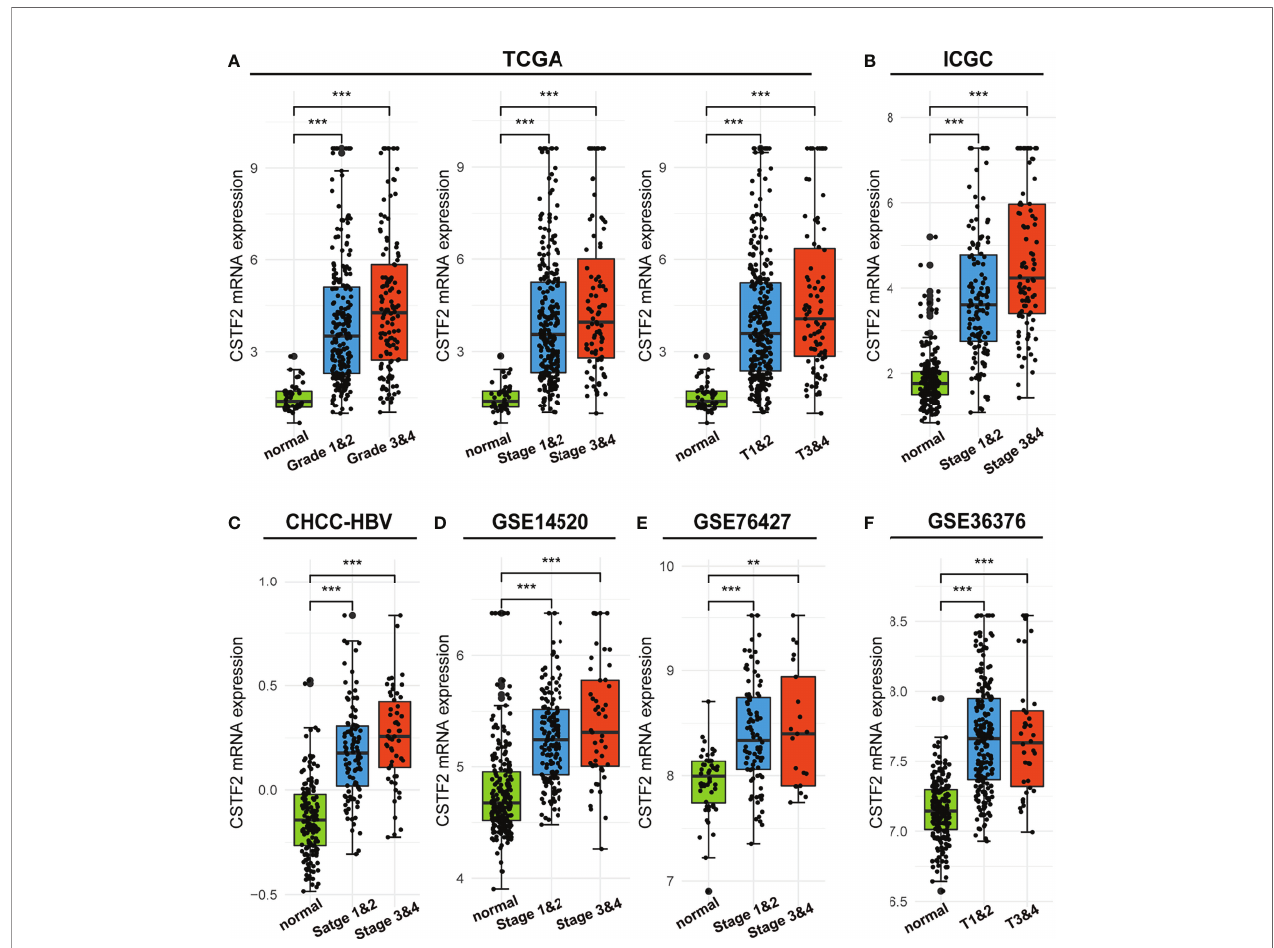
FIGURE 3 | The mRNA levels of CSTF2 were correlated with the advanced clinical stage in HCC in different databases. (A-F) The relationship between CSTF2 expression levels with a histological grade, a clinical stage in TCGA databases, ICGC databases, CHCC-HBV databases, GSE14520 databases, and GSE76427 databases and in GSE36376 databases. ** r < 0.01, *** p < 0.001 compared to